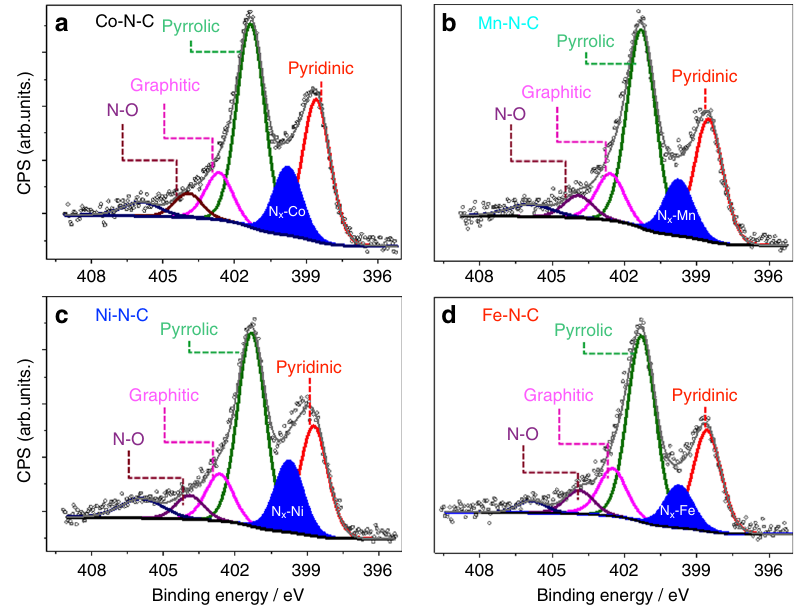
Fig. 2 High-resolution XPS characterization. N-1s XPS core level region of a Co, b Mn, c Ni and d Fe doped M – N – C catalyst. The 2p 3/2 spectra of the corresponding metal peaks (Co-2p, Mn-2p, Ni-2p, Fe-2p) is shown in Supplementary Fig.